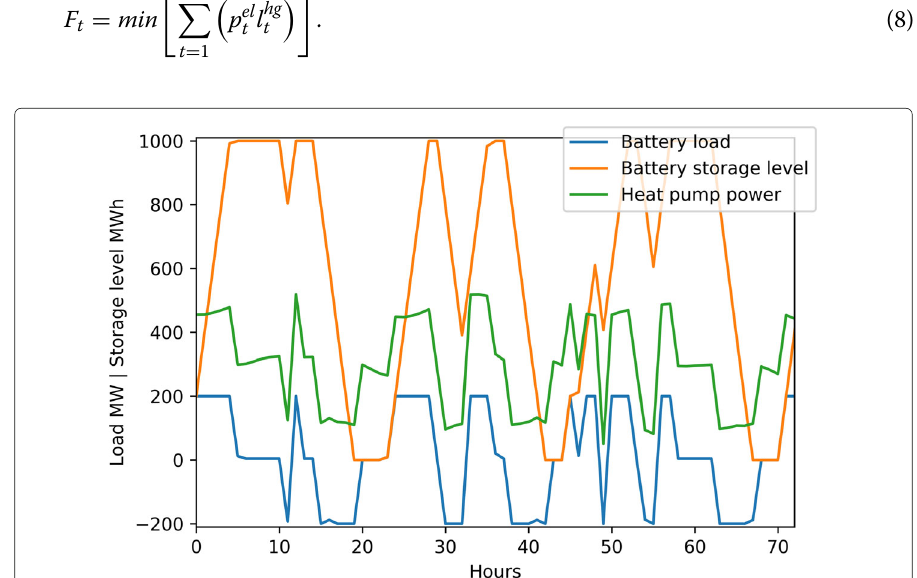
Fig. 2 Heat pump operation, heat storage load and heat storage status for the online control